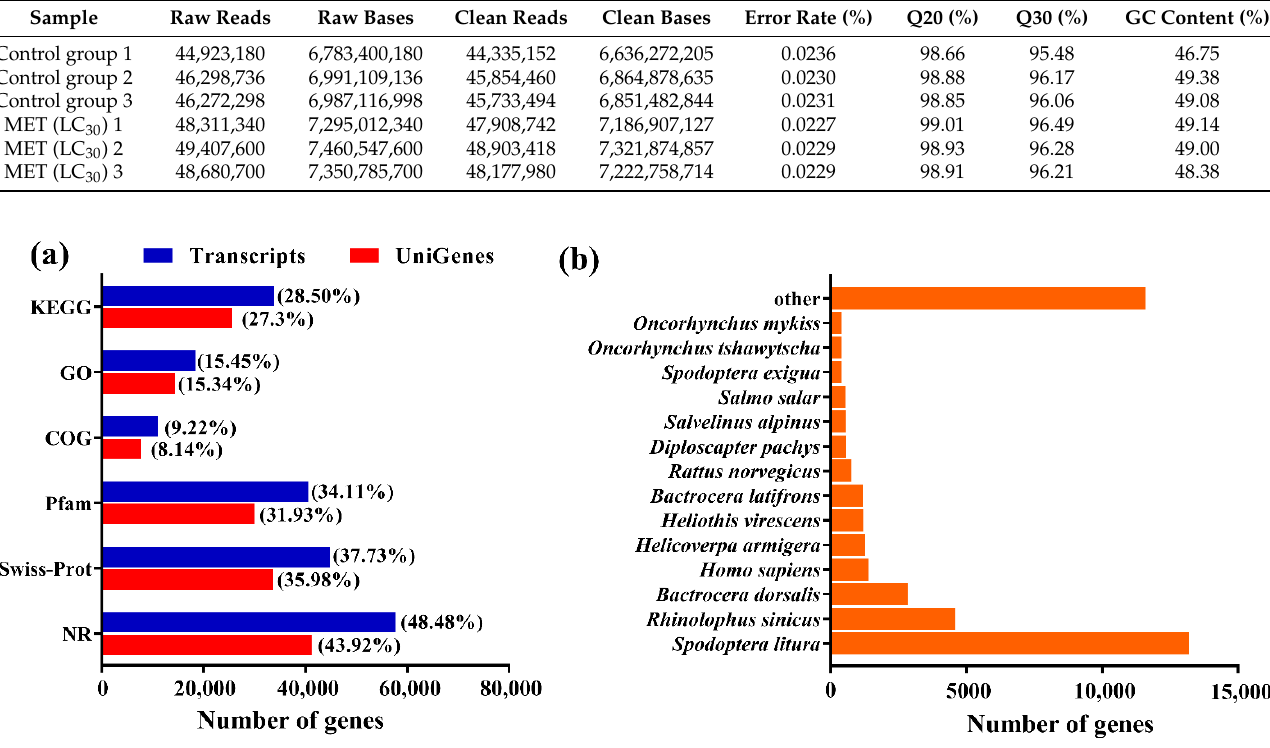
Table 1. Date control statistics of transcriptome of S. exigua.